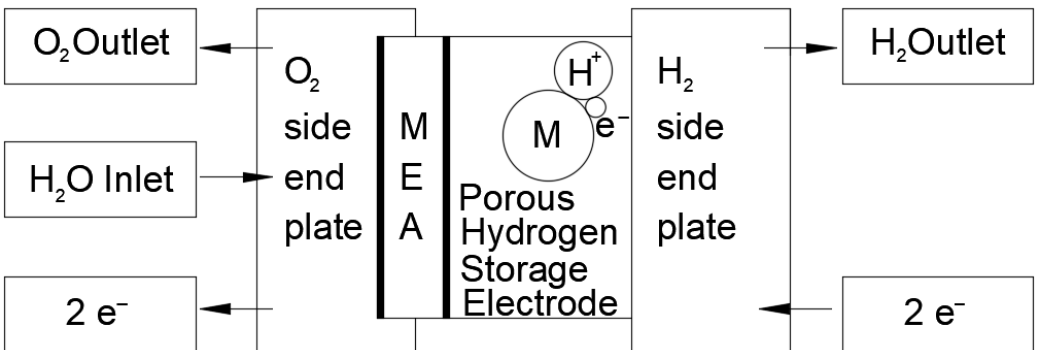
Figure 1. Representing the charging mode or electrolysis mode of the proton battery.